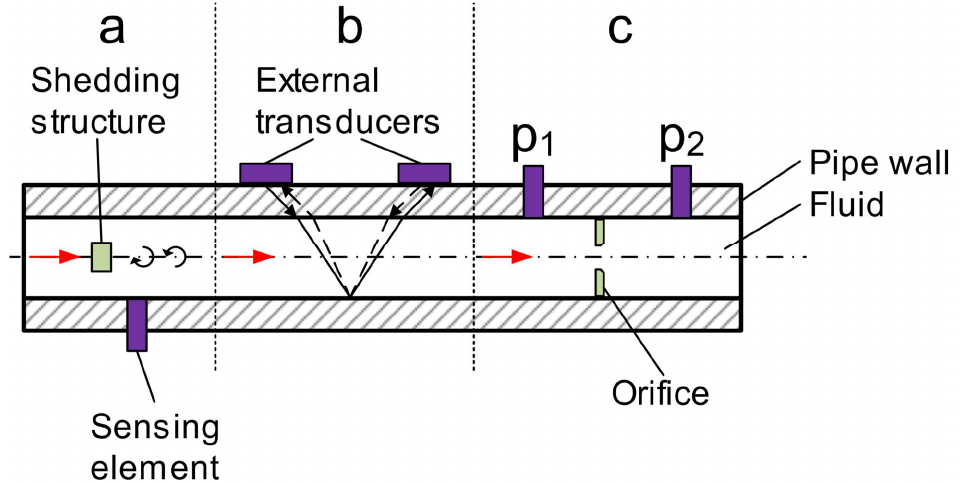
Figure 4. Volumetric flow meters, ( a ) vortex type with shedding structure and sensing element behind structure, ( b ) ultrasonic clamp-on flow meter with downstream ultrasonic path in filled line, upstream path with dashed line, ( c ) pressure drop flow meter with orifice plate.